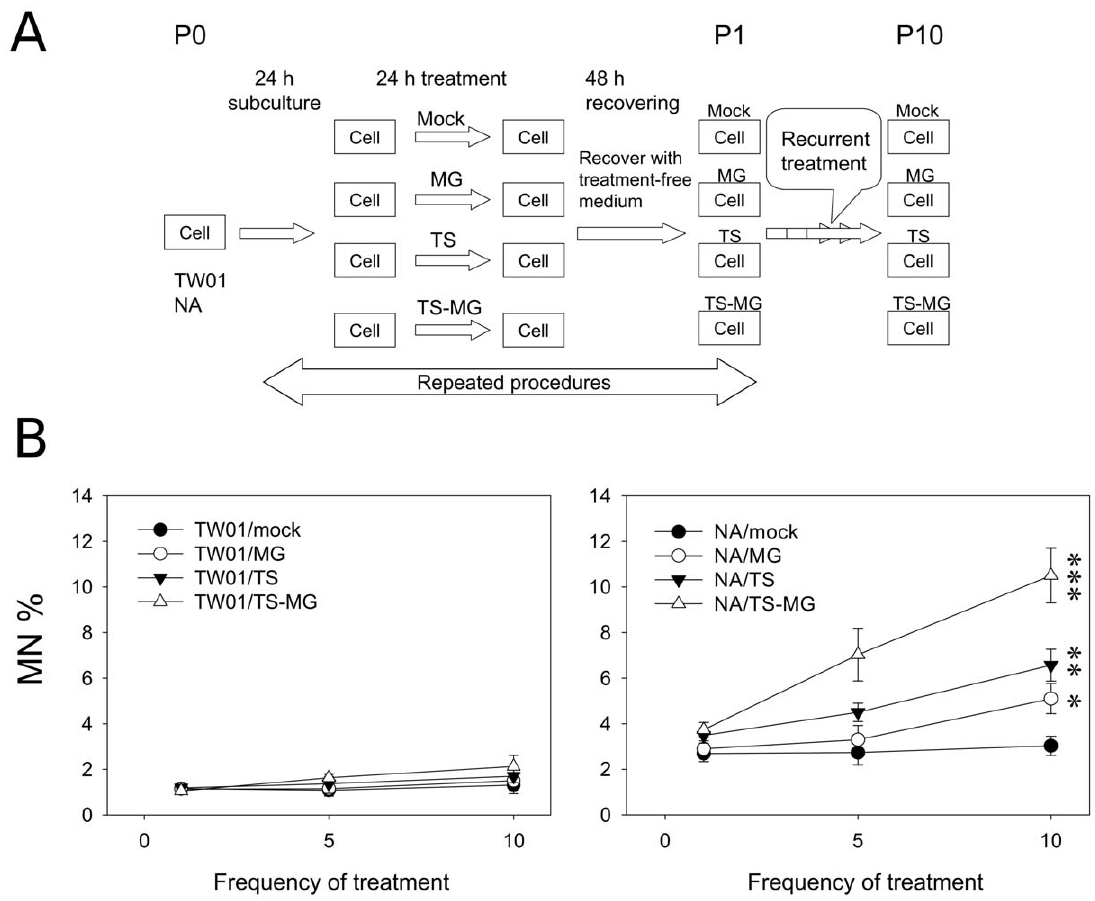
Figure 2. Recurrent EBV reactivation concomitant with progressive genome instability in NPC cells. (A) Representative illustration of recurrent chemical treatment in NPC cells. Cells were mock or treated repeatedly with indicated chemicals. The cells at the beginning of this experiment were defined as passage 0 (P0) cells. After seeding, the cells were subjected to a 24 h period of mock or chemical treatment, and then were recovered by replacing with fresh medium for a further 48 h. The resulting cells were defined as passage 1 and the procedure was repeated for ten times. ‘‘P n ’’ represents treated NPC cells, where n stands for the passage number of the cells. MG, TS and TS-MG indicate cells treated with MNNG, TPA/SB, and TPA/SB combined with MNNG, respectively. (B) Cells were stained with Hoechst 33258 and MN was examined using a fluorescence microscope. Occurrence of MN formation (MN%) is presented here as the percentage of the number of micronuclei-presenting cells per 1,000 cells analyzed and plotted as a function of the frequency of chemical treatment. At least 1,000 cells were counted for each experiment. Data indicate mean value in MN% (triplicates 6 SD). *: p , 0.05, **: p , 0.01, ***: p , 0.001, when compared to NA-P10/mock cells. Table 1. Carcinogenesis-related clusters, including apoptosis, protease/peptidase, cell proliferation, response to extra/intra- cellular stimuli, and lipid/steroid metabolic processes were found to be altered (Table 1). Genes involved in five categories, including apoptosis, peptidase activity, cell proliferation, cell adhesion and antigen presentation, are presented in Table 2. Downregulation of apoptotic genes, such as DAPK2, HRK, TP53INP1, and upregulation of anti-apoptotic genes, including BCL11B, BAG1, SERPINB2, were noted. Genes involved in cell proliferation, including CCND2 and CDK6 were upregulated while CDKN1A, CDKN2B, IFITM1 and IGFBP7 were downregulated. Down- regulation of many peptidases, including several kallikrein-related peptidases (KLK5, 6, 7, 8, and 10) and complement components (C1R, C1RL, C1S, and C2/CFB) also were observed. Repression of serine protease inhibitor SLPI and matrix metalloproteinases (MMP) inhibitor TIMP2 also were noted. MHC genes that are involved in antigen presentation, including HLA-B/-C/-F/-G, and genes responsible for antigen processing, CTSB and HSPA2, were underexpressed after recurrent EBV reactivation. The